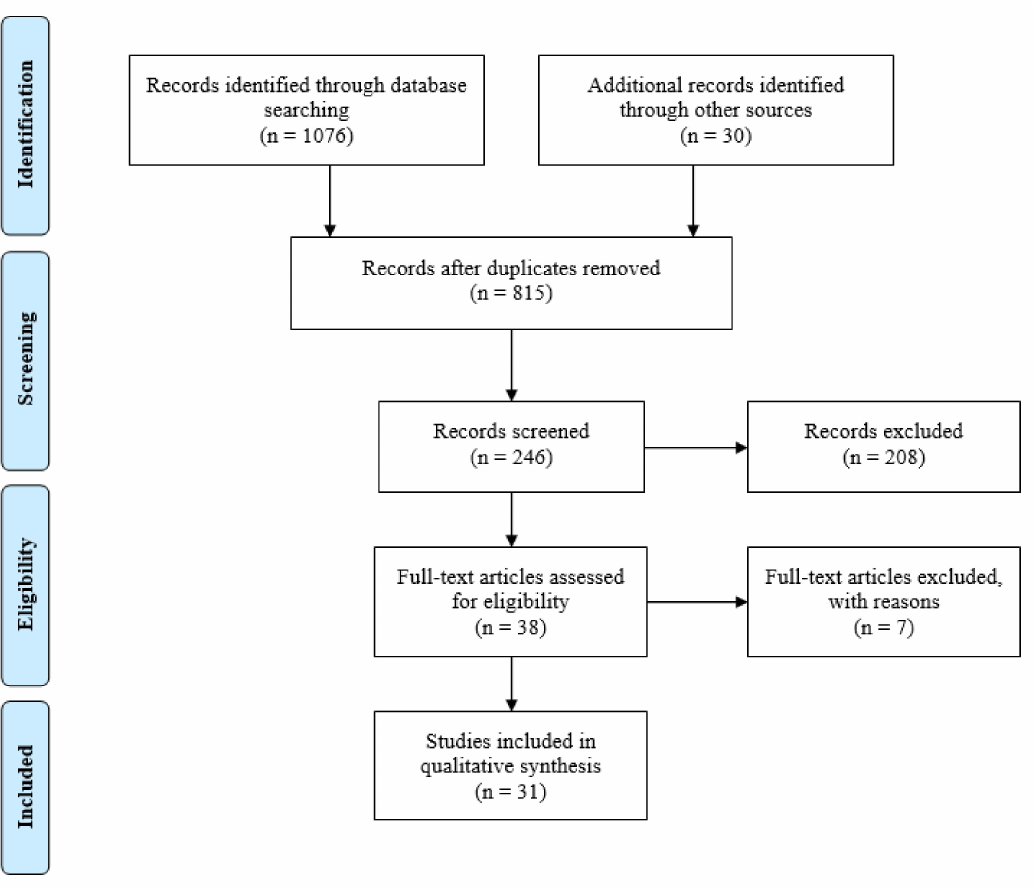
Figure A1. PRISMA Flowchart for analyzed studies.